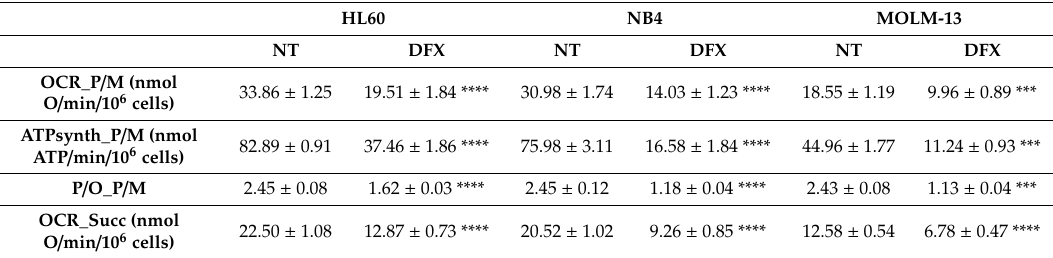
Table 1. Iron chelation induced a decrement of oxygen consumption, ATP synthesis and a less e ffi cient OxPhos in acute myeloid leukemia cell lines. The table reports the oxygen consumption rate (OCR) and the ATP synthesis (ATPsynth) through F0-F1 ATP synthase in acute myeloid leukemia cell lines untreated (NT) or treated with DFX. These activities have been evaluated in the presence of pyruvate / malate (P / M) or succinate (Succ), to investigate the OxPhos pathways triggered by complex I or complex II, respectively. The P / O value is calculated as the ratio between ATPsynth and OCR and represents a marker of mitochondrial e ffi ciency. Literature reports that a complete e ffi ciency is observed when the P / O ratios are 2.5 or 1.5 in the presence of pyruvate / malate or succinate, respectively [55]. Data are expressed as mean + standard deviation (SD) and are representative of three independent experiments. *** or **** indicate a p < 0.001 or p < 0.0001 respectively, between the same untreated or DFX-treated